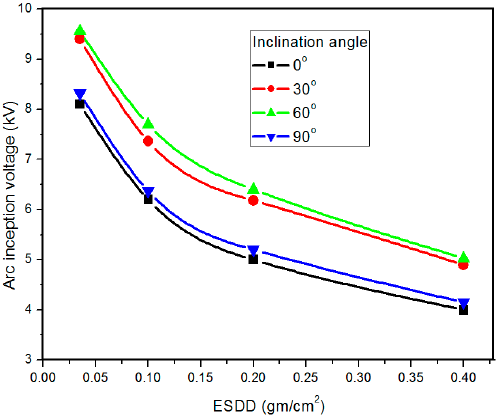
Figure 12. Arc inception voltage at different inclination angles, where pollution distribution = uniform, NSDD = 0.75 mg/cm 2 , humidity level = low, temperature = 10 °C, and standard deviation = 2.3%–5.1%.